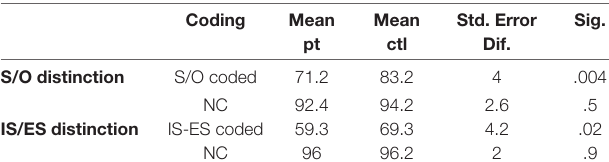
TABLE 2 | Group differences in the percent of correct recognition of sentences that were agency (S/O) or spatially (IS-ES) coded and those that were not agency or spatially coded (NC).